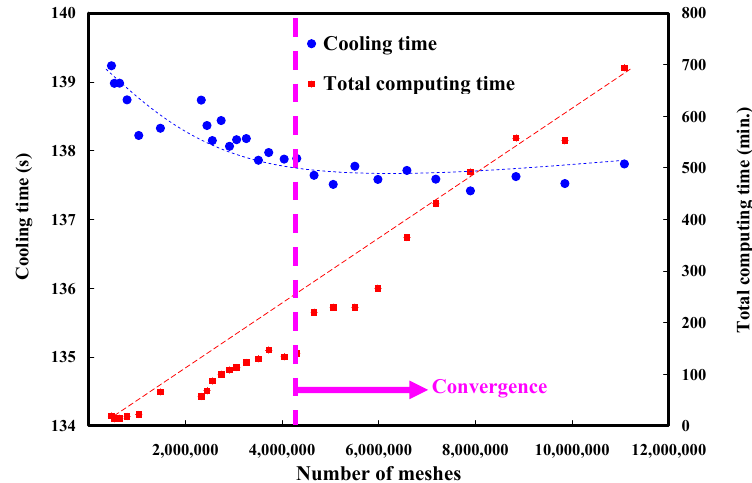
Figure 10. Number of meshes as a function of cooling time and total computing time of numerical analysis.